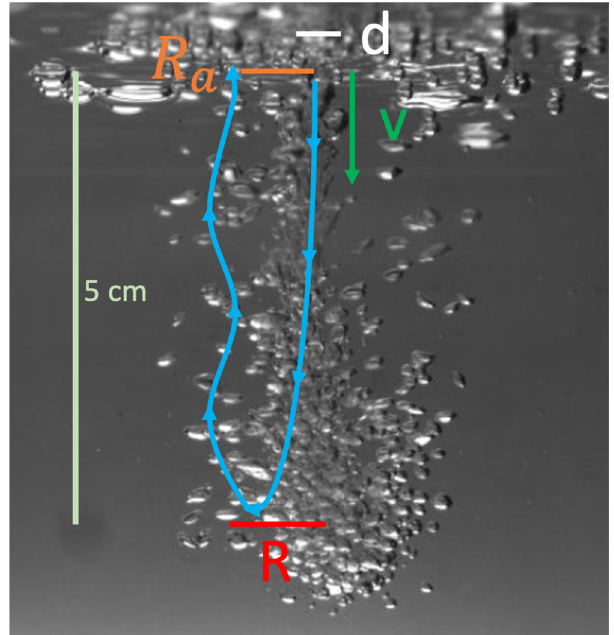
Fig. 3. Example of flow of bubbles created underwater by the jet. R is the largest radius of the flow, v is the impact velocity, d is the diameter of the plunging jet, in blue we have the trajectory of an average bubble with R a the radius of emergence at the